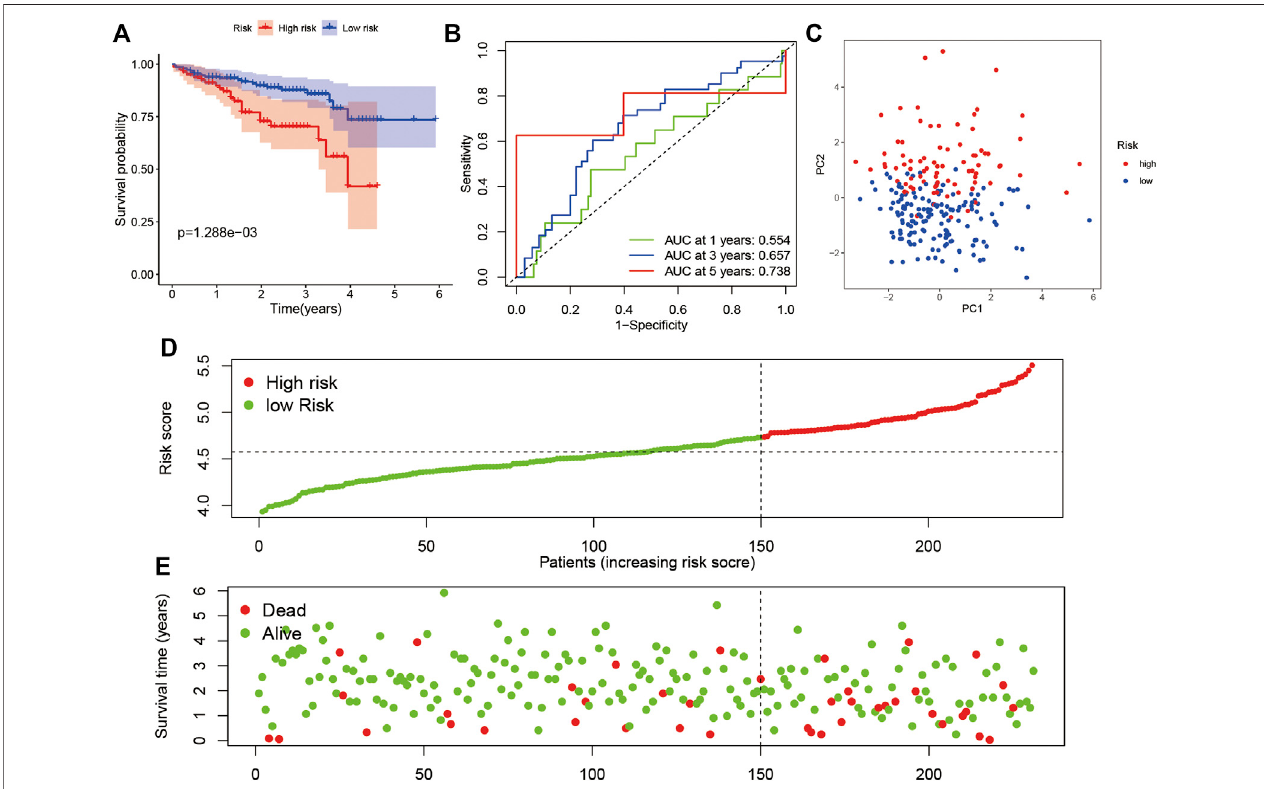
FIGURE 4 | Veri fi cation of the risk model in the ICGC dataset. (A) Survival analysis in the two risk subgroups. (B) AUC of the risk model. (C) PCA plot. (D) The risk score of LIHC in the ICGC dataset. (E) Distribution of survival status.